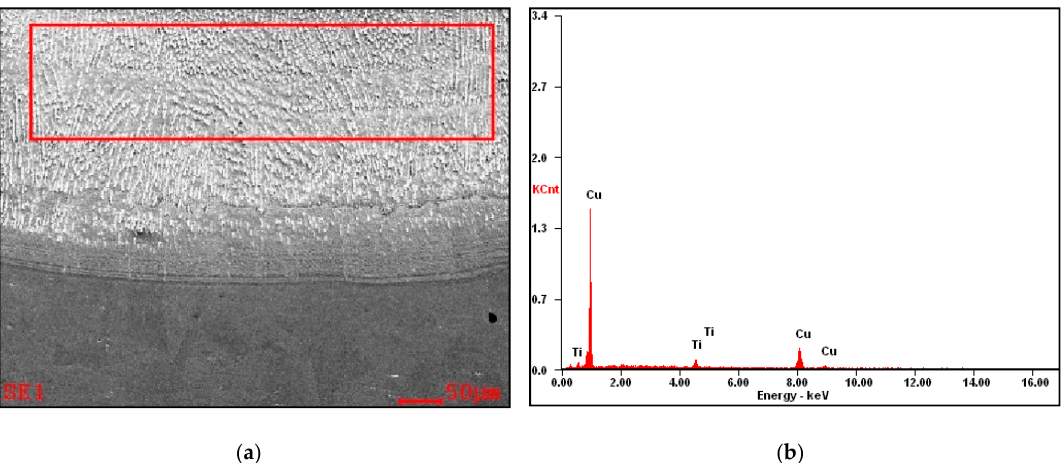
Figure 9. ( a ) The microstructure of the copper surface-alloyed with titanium, and ( b ) analysis of EDS